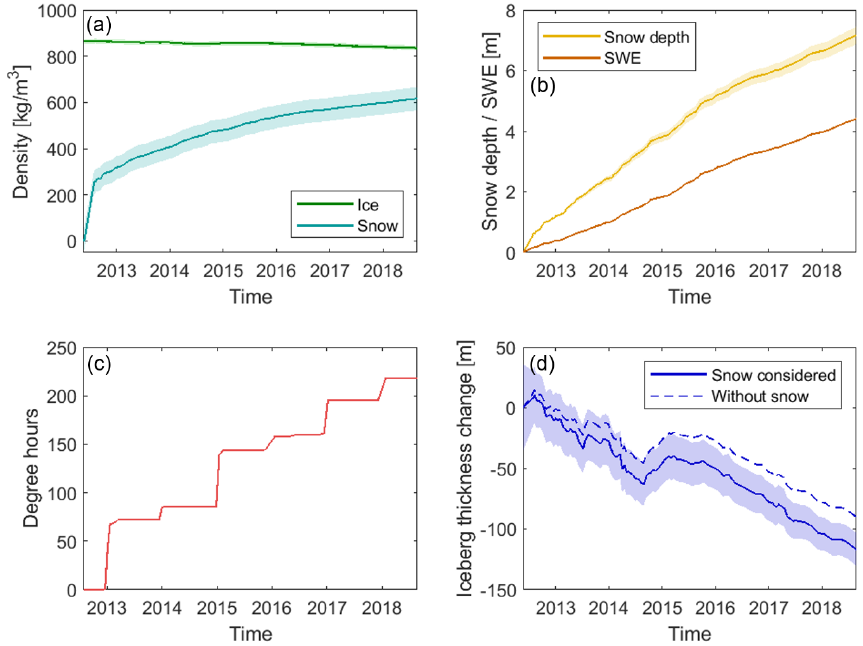
Figure 8. Evolution of the B30 iceberg properties: (a) ice density and snow density, (b) snow water equivalent (SWE) and snow depth accumulation on the B30 iceberg, (c) degree hours that the B30 iceberg experienced, and (d) thickness change in the B30 iceberg with and without snow accumulation taken into consideration. Uncertainties are plotted as shaded areas.